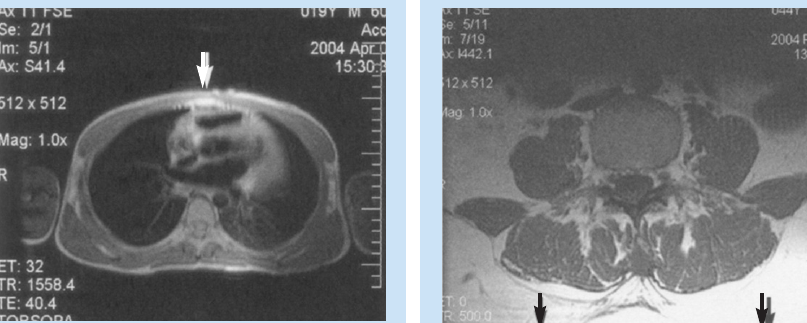
Fig. 10. Surface coil artefact: high signal at anteri- or thoracic wall adjacent to surface coil.